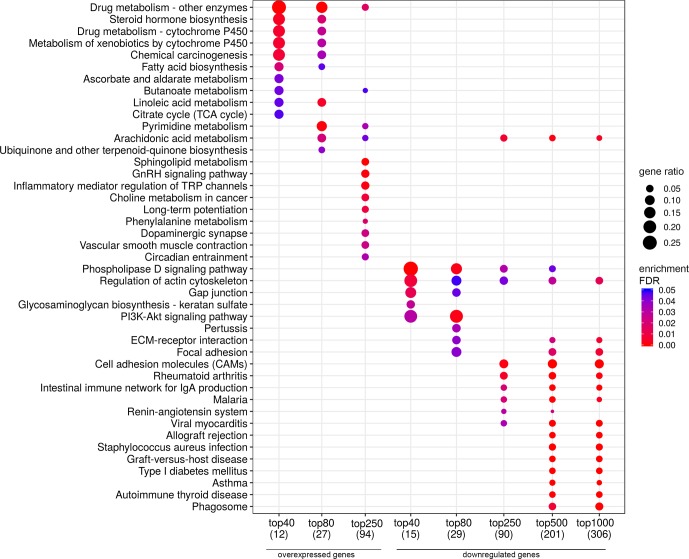
Dotplot showing the results of KEGG pathways enrichment analyses performed for top-40, 80, 250, 500, and 1,000 differentially expressed genes (either overexpressed or downregulated) between the groups of adverse and favorable prognosis (Russian patient cohort). All the genes have passed the following thresholds: DESeq p-value < 0.01, Mann–Whitney p-value < 0.05, average expression-level fold change > 25%. Dot size indicates k/n ratio (“gene ratio”), where k is the number of genes participating in the current KEGG pathway (within top-40, top-80 or other top lists), and n is the number of genes (also within top-40, top-80, or other top lists) annotated as participants of any KEGG pathway (these numbers are provided in the brackets in the bottom of the figure). Dot color indicates the enrichment test FDR (Fisher’s exact test).